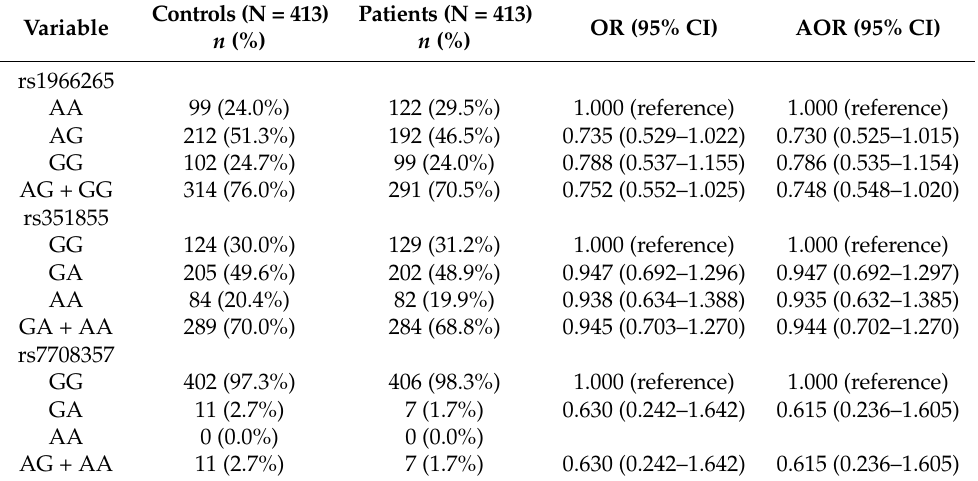
Table 2. Genotype distributions of FGFR4 gene polymorphisms in 413 controls and 413 patients with